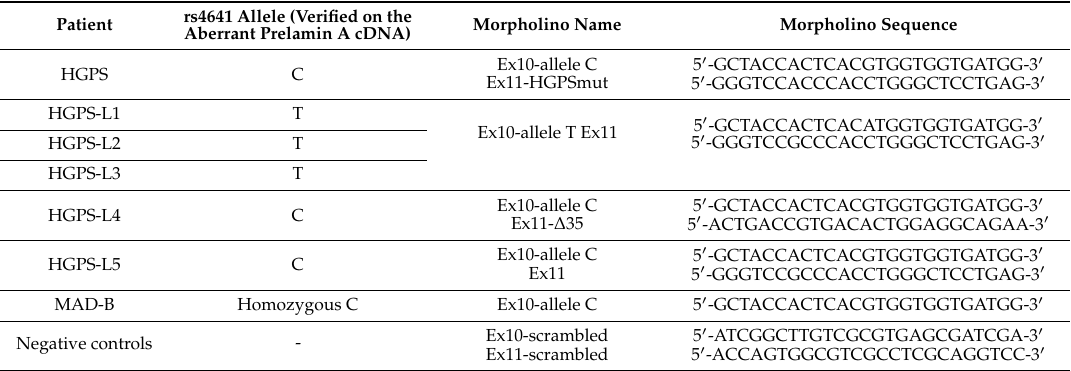
Table 1. Morpholino oligonucleotides’ sequences used in this study depending on each patient’s LMNA genotype at exons 10 and 11 target